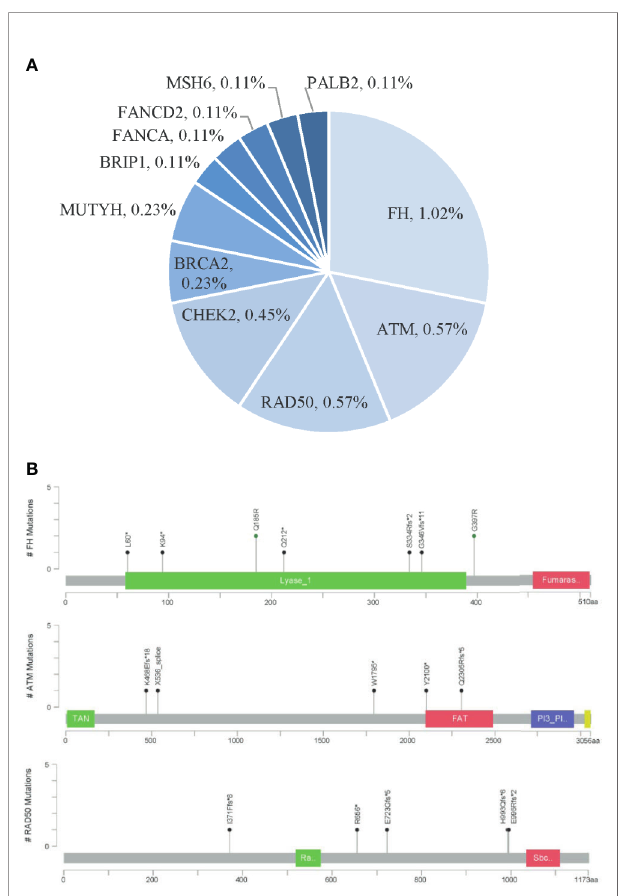
FIGURE 3 | Somatic DDR alterations and TMB. (A) Distribution of DDR gene mutations. (B) Discrepancies of TMB between DDR-mutant and DDR-wild type group. DDR, DNA damage repair; TMB, tumor mutational burden. ***p < 0.001.